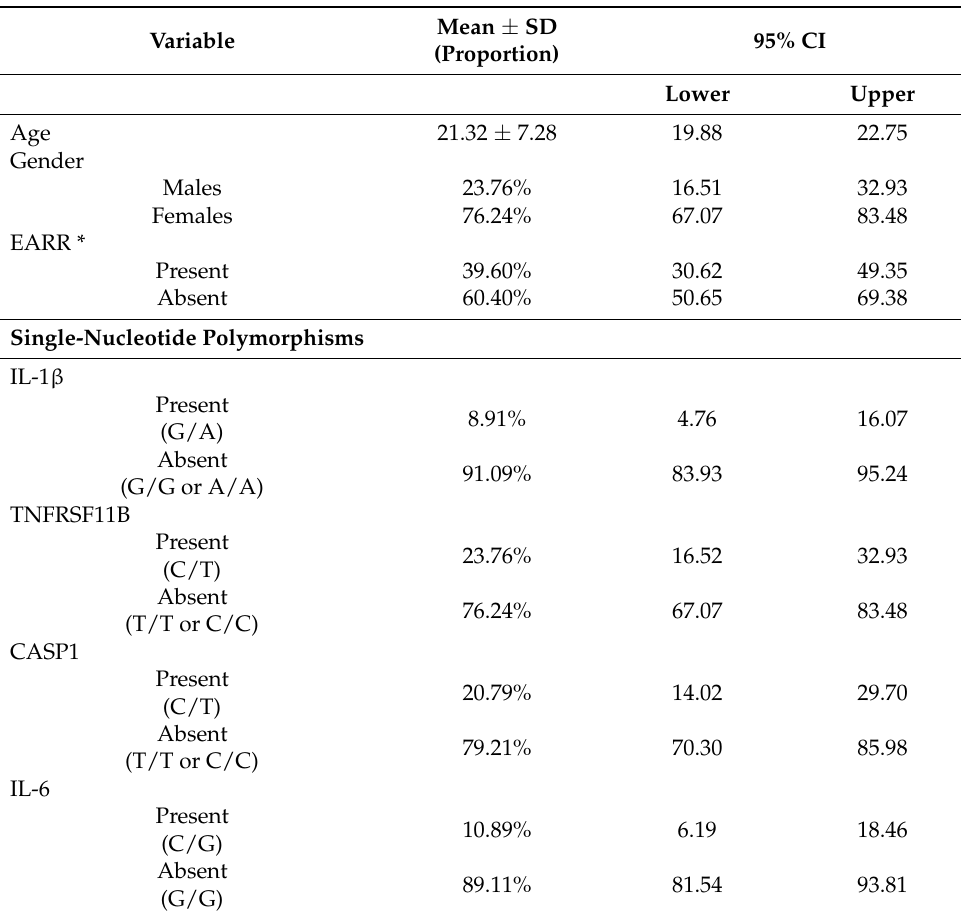
Table 1. Descriptive statistics of patients’ characteristics and genetic polymorphisms.